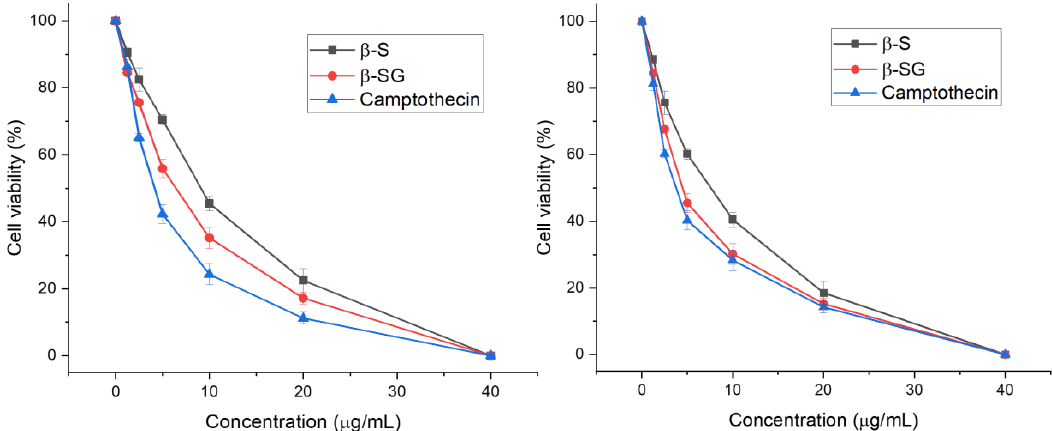
Figure 4. Cytotoxicity of the compounds and camptothecin on HepG2 ( A ) and Huh7 ( B ) cells at different concentrations.